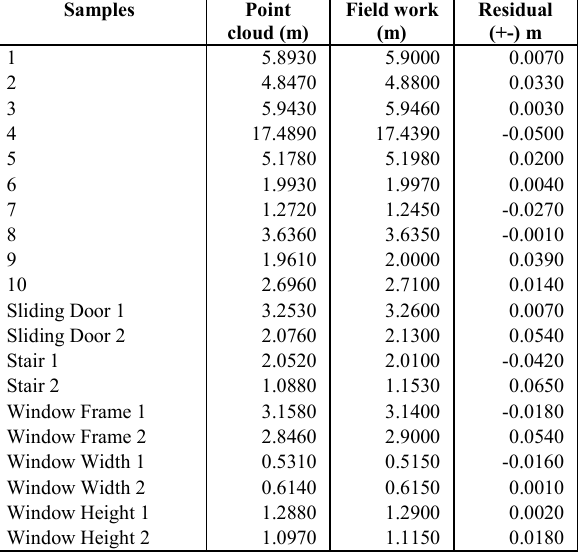
Table 1. Residual value from integration data and field work data.